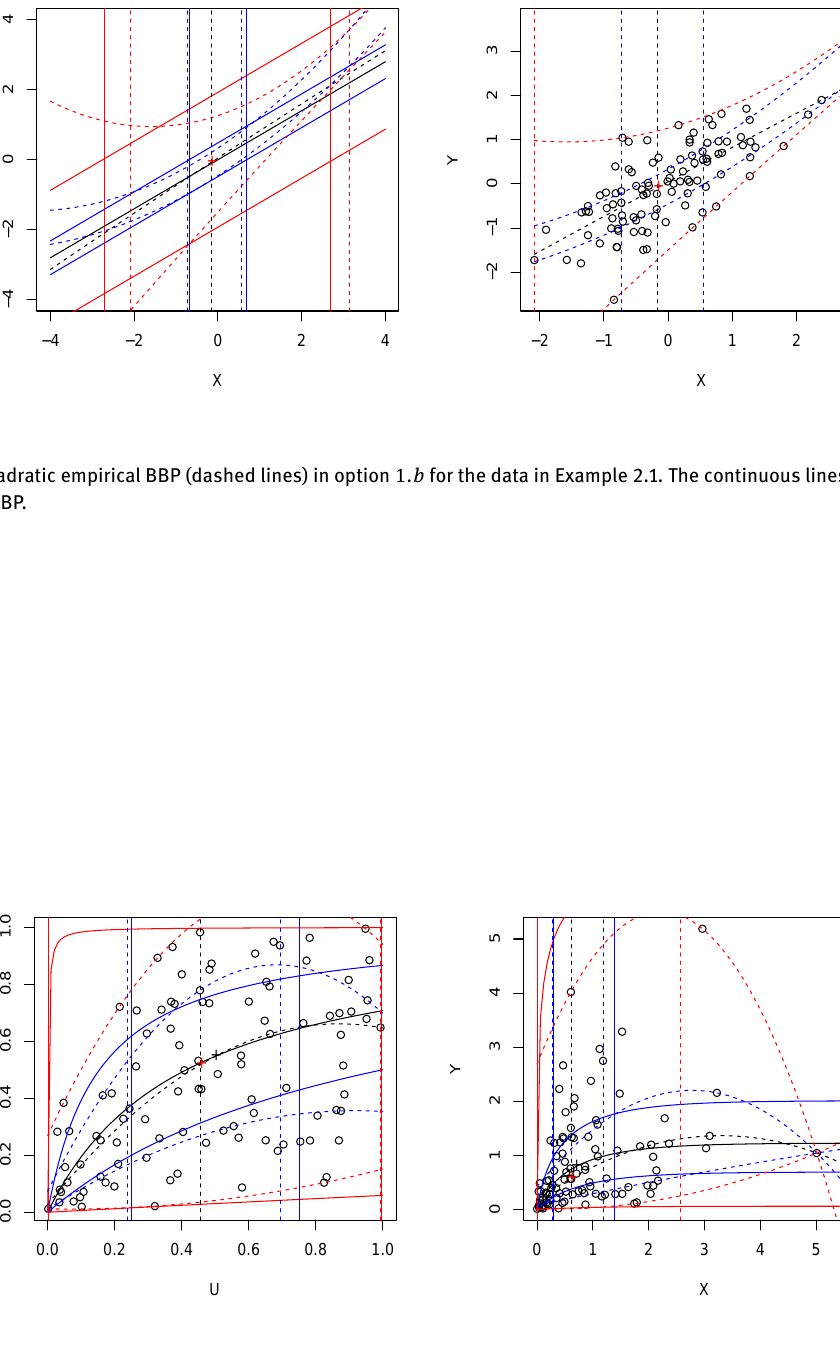
Figure 10: Quadratic empirical BBP (dashed lines) in option 1. b for the data in Example 2.2 with uniform (left) and standard exponential (right) marginals. The continuous lines represent the theoretical